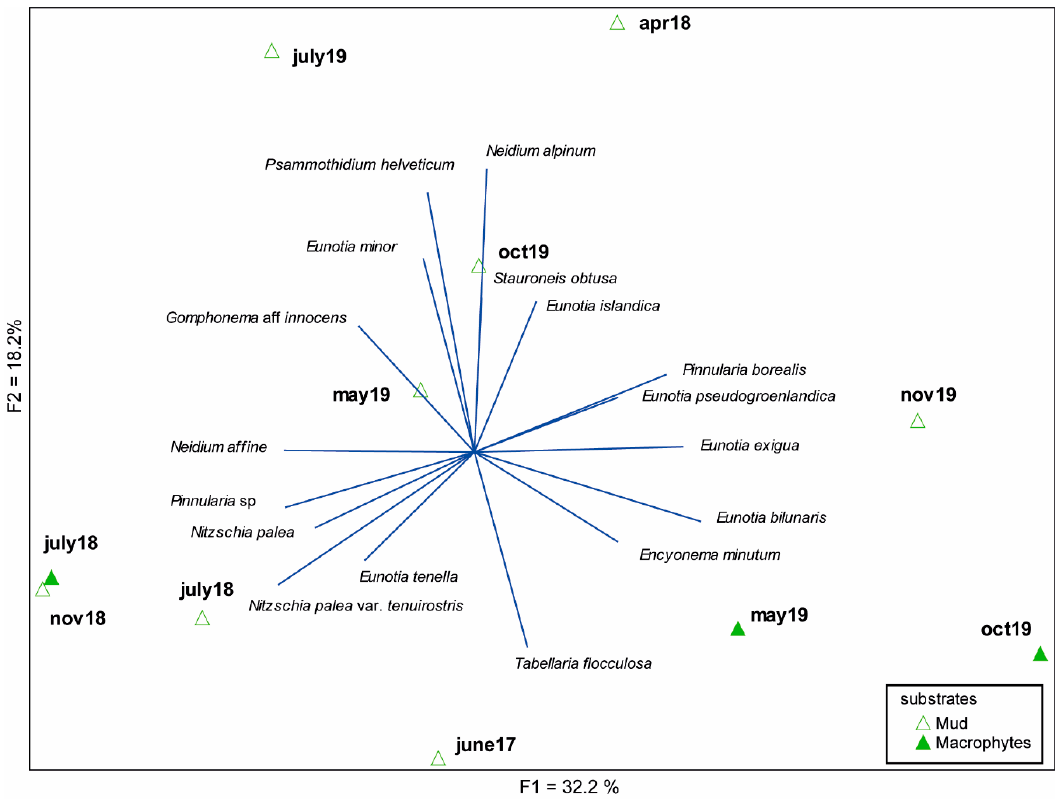
Figure 7. Principal component analysis performed on diatoms observed at each sampling period (relative abundance >1% in at least one sample).